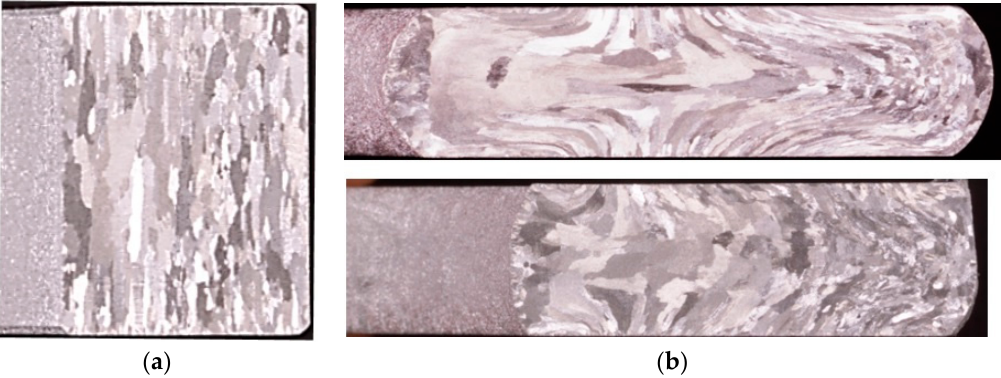
Figure 15. Metallographic specimen of the pre-deformed ring ( a ), and of the deformed unlubricated specimen R5 ( top ) and lubricated specimen R13 ( bottom ) ( b ) both tested at 450 °C .